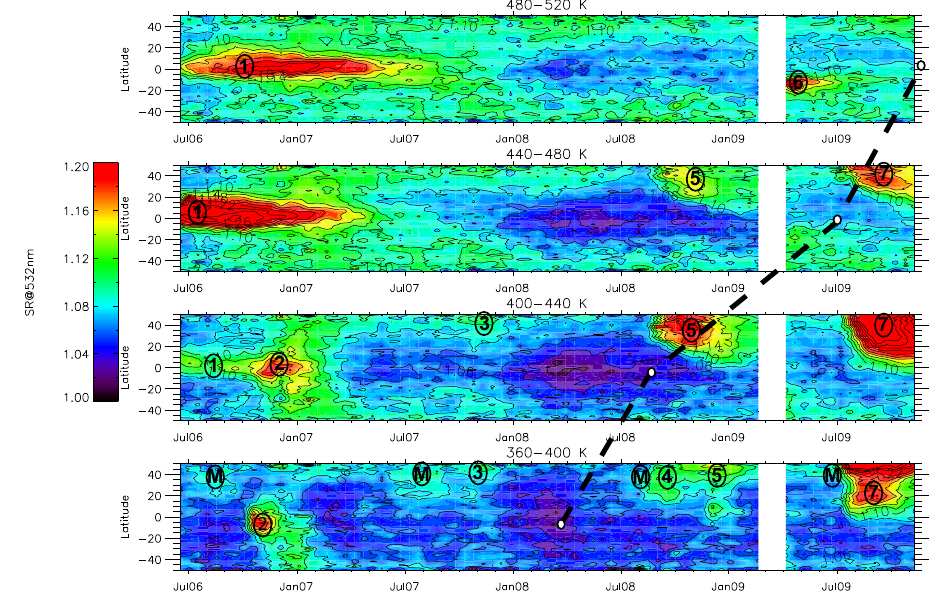
Fig. 2. Latitude-time cross-sections of CALIOP SR within 40K (1.5km) thick layers centred at 380K (17km), 420K (18.5km), 460K (20km) and 500K (21.5km) from June 2006 until October 2009. The black dotted curve shows the timing of the uplift of clean air if it was due to slow ascent by radiative heating as calculated by Yang et al. (2008). Letter M corresponds to the aerosol feature associated with the Asian monsoon.